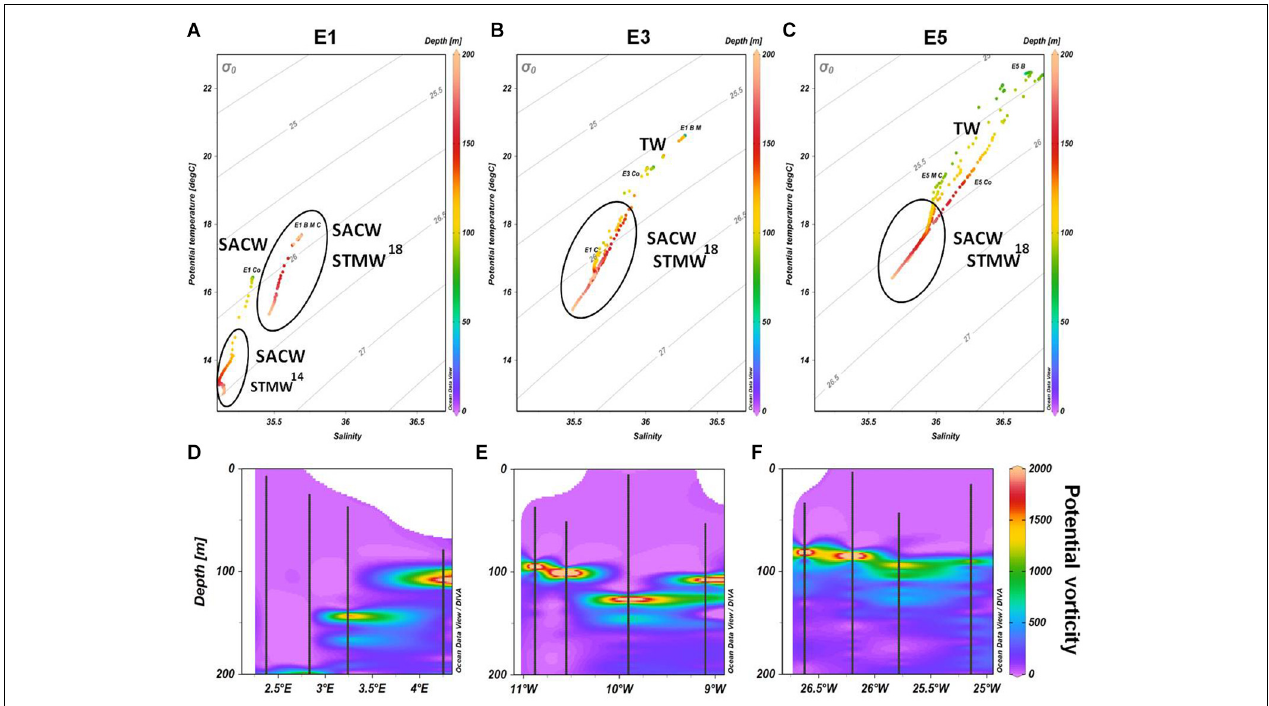
FIGURE 2 | (A–C) TS (Temperature and Salinity) Diagrams for eddies E1, E3, and E5, respectively, from the surface to 200 m. The continuous black ellipses denote the water masses found in each eddy. (D–F) Potential vorticity Q (10 − 12 m − 1 . s − 1 ) of the three eddies (E1, E3, and E5, respectively) from 0 to 200 m depth. The black points forming lines indicate the CTD